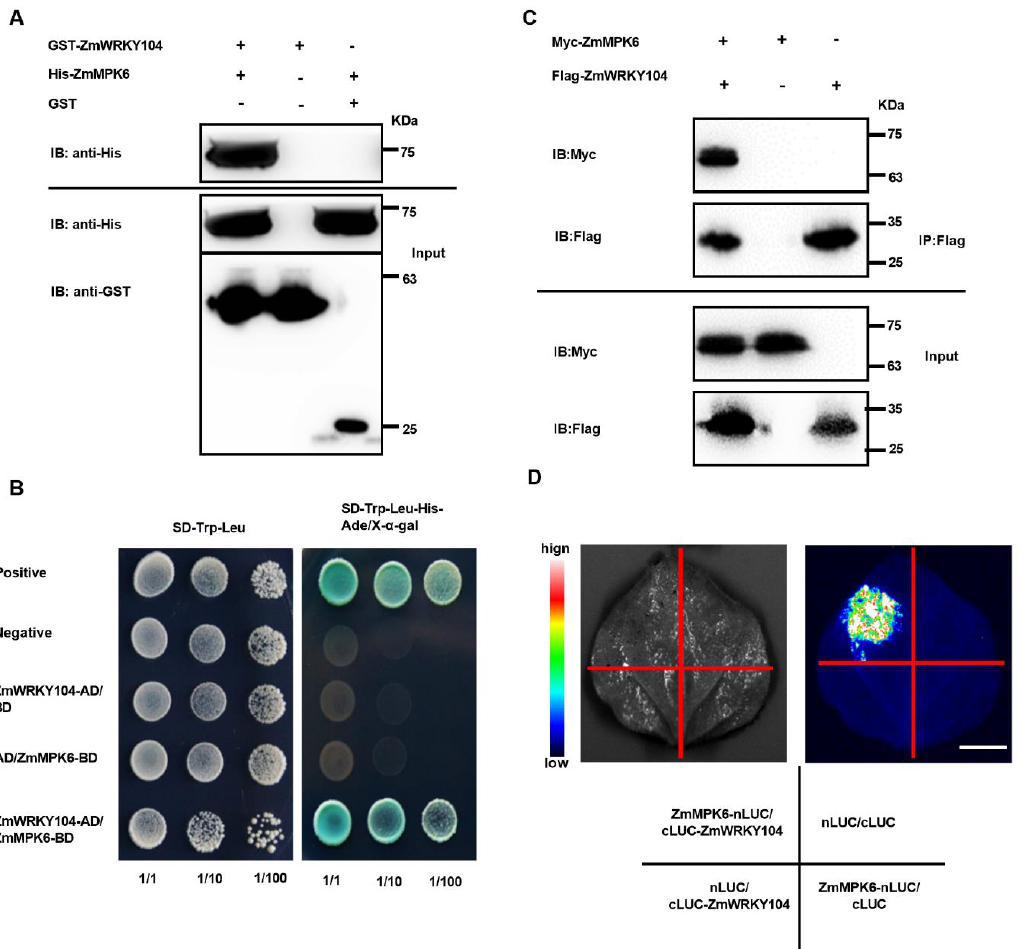
Figure 4. The interaction between ZmWRKY104 and ZmMPK6. ( A ) Pull−down assay. GST or GST−ZmWRKY104 fusion protein was incubated with His−ZmMPK6 in GST beads. His−ZmMPK6 was detected using an antibody of anti−His by Western blot. GST−ZmWRKY104 and GST were detected using an anti−GST antibody by Western blot. Molecular masses are marked on the right; ( B ) Y2H assay. AD−vector and BD−vector were Y2H vectors with no insert. To test the interaction, the medium of SE−Trp−Leu−His−Ade/X−α−gal was used. pGBKT7−53/pGADT7−T was used as a positive control, and pGBKT7− lam /pGADT7−T was used as a negative control; ( C ) Co−IP assay. 35S:Myc− ZmMPK6 and 35S:Flag− ZmWRKY104 were co−expressed in four−week−old Nicotiana benthamiana leaves. Proteins were immunoprecipitated (IP) with Flag antibody and analyzed by immunoblot (IB) using anti−Flag and anti−Myc antibodies. Molecular masses are marked on the right; ( D ) LCI assay. ZmMPK6 was fused to nLUC, and ZmWRKY104 was fused to cLUC. ZmMPK6−nLUC and cLUC−ZmWRKY104 were then co−expressed in Nicotiana benthamiana leaves. nLUC/cLUC−ZmWRKY104, ZmMPK6−nLUC/cLUC, and nLUC/cLUC were used as negative controls. Luciferase signals were captured using the Tanon 5200 image system. Scale bar = 1 cm. All experiments were repeated at least three times with similar results.